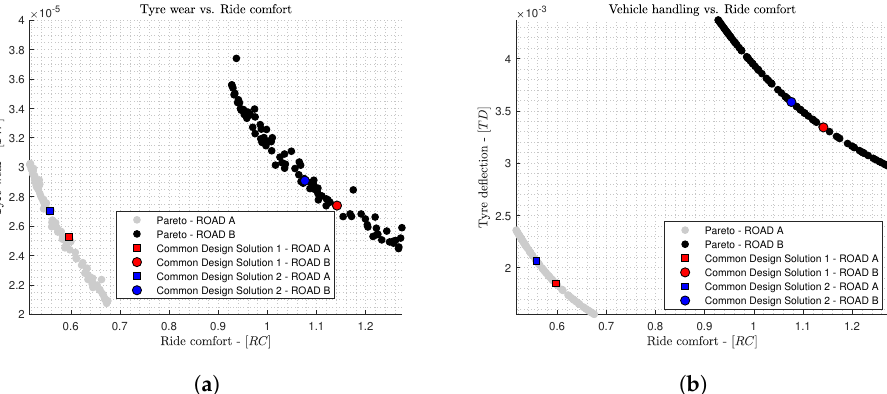
Figure 8. Comparison of the optimum solutions obtained for the two optimisation cases (class A and B road profiles) in Scenario 1: ( a ) TW vs. RC; and ( b ) TD vs.